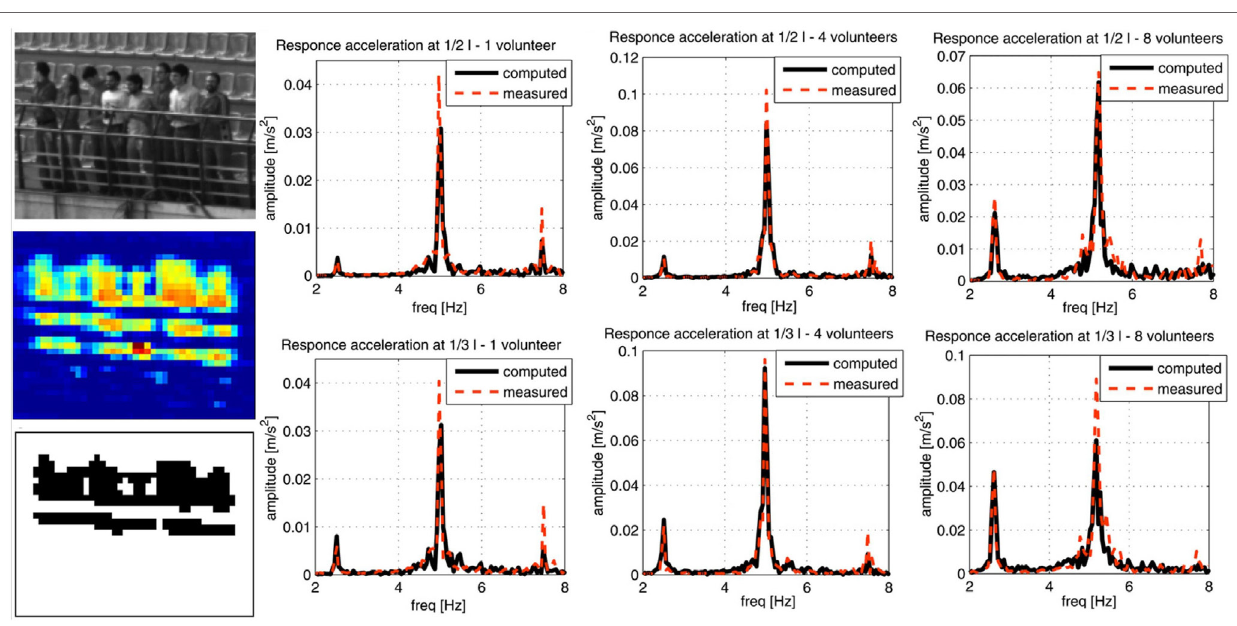
FiGURe 7 | Comparison between measured and computed structural acceleration; tests at 2.5 Hz. Reprinted from (Mazzoleni and Zappa, 2012) with permission from